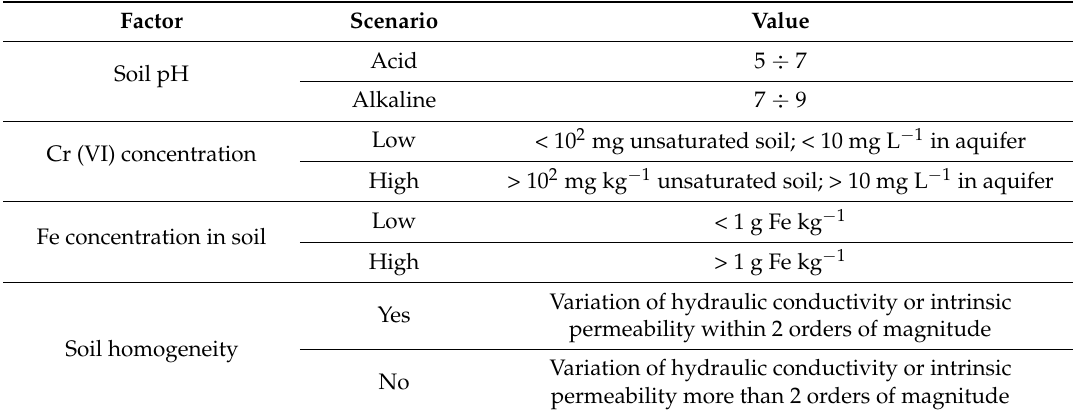
Table 2. Factors which influence the choice of